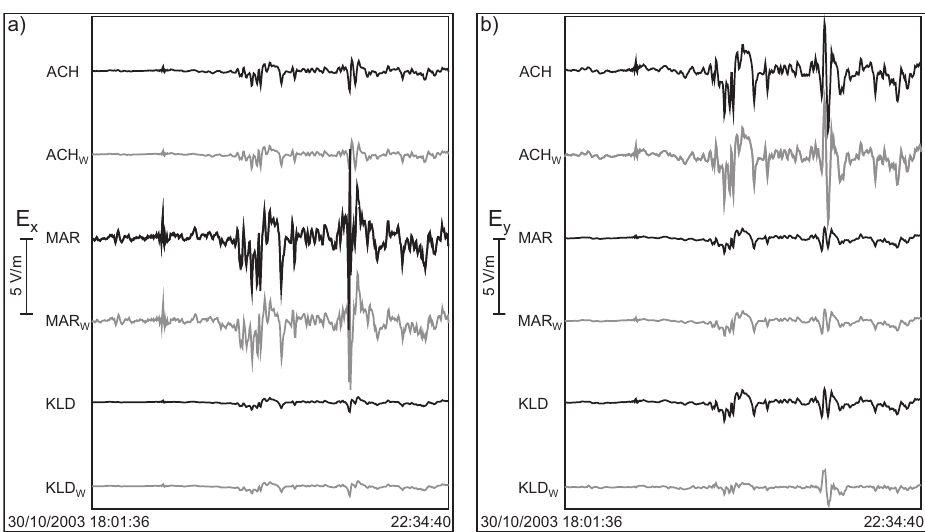
Fig. 6. Estimated (a) north – south polarised electric fi eld ( E x ) time series; (b) east – west polarised electric fi eld ( E y ) time series decimated to a sample rate of 32 s for 3 sites in Scotland during the Halloween 2003 magnetic storm obtained through frequency-domain multiplication of site- dependent impedance tensors with magnetic time series from ESK observatory. Subscript “ W ” denotes use of impedances modi fi ed to take into account horizontal magnetic fi eld gradients embodied in the perturbation tensor. Other time-series traces are for measured impedances. Peak electric fi eld fl uctuations occur at the same time for both E x and E y